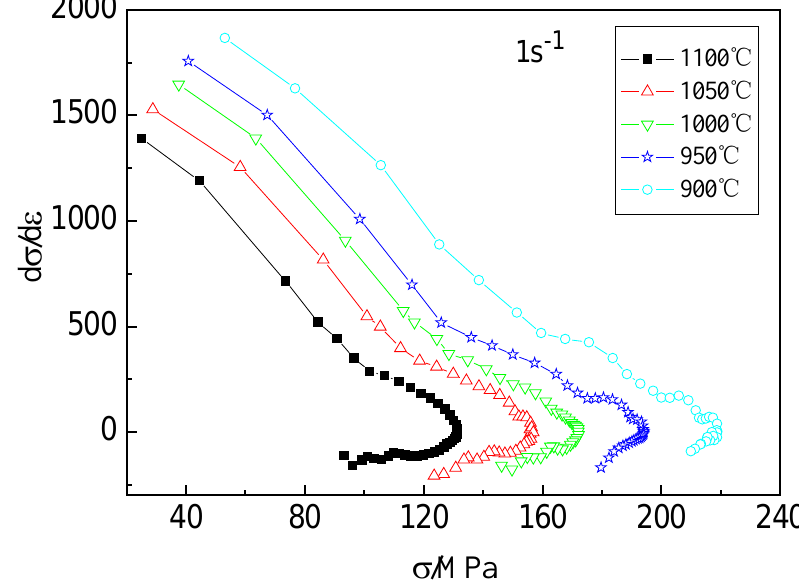
Figure 6. Strain hardening curves of the examined steel at 1 s − 1 and different temperatures.